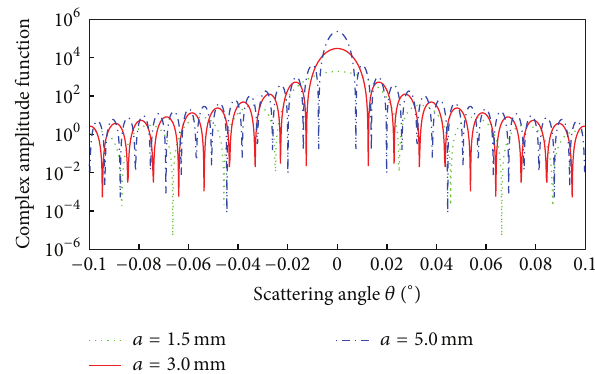
Figure 2: Diffraction of elliptical section obtained by 𝛽 = 0.8 for different sizes.